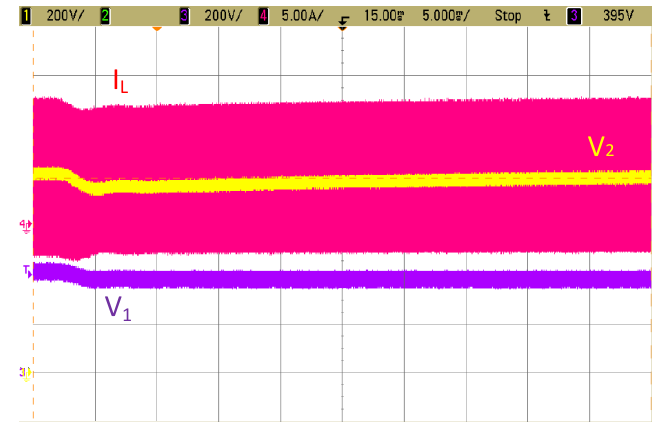
Figure 14. Dynamic behavior of the PI regulator over a step in the input voltage. V 1 changes from 400 V to 350 V, keeping V 2 = 800 V. V 1 (violet), I L (pink) and V 2 (yellow).